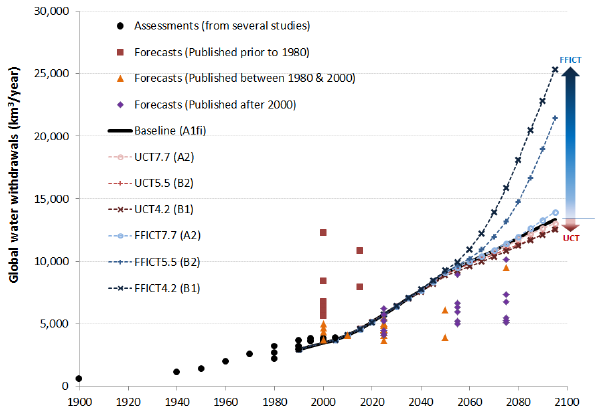
Figure 7: Global water withdrawals for the baseline and the six policy scenarios in comparison to literature estimates of historical water use and other studies; sources: Gleick 2003 (and references therein), Falkenmark & Rockström, 2000, Alcamo et al. 2003a, Figure 7. Global water withdrawals for the baseline and the six pol- Alcamo et al. 2003b, Shiklomanov & Rodda, 2003, Alcamo et al., 2007, Shen et al. 2008, Wada et al., 2011, and AQUASTAT 2011 icy scenarios in comparison to literature estimates of historical wa-